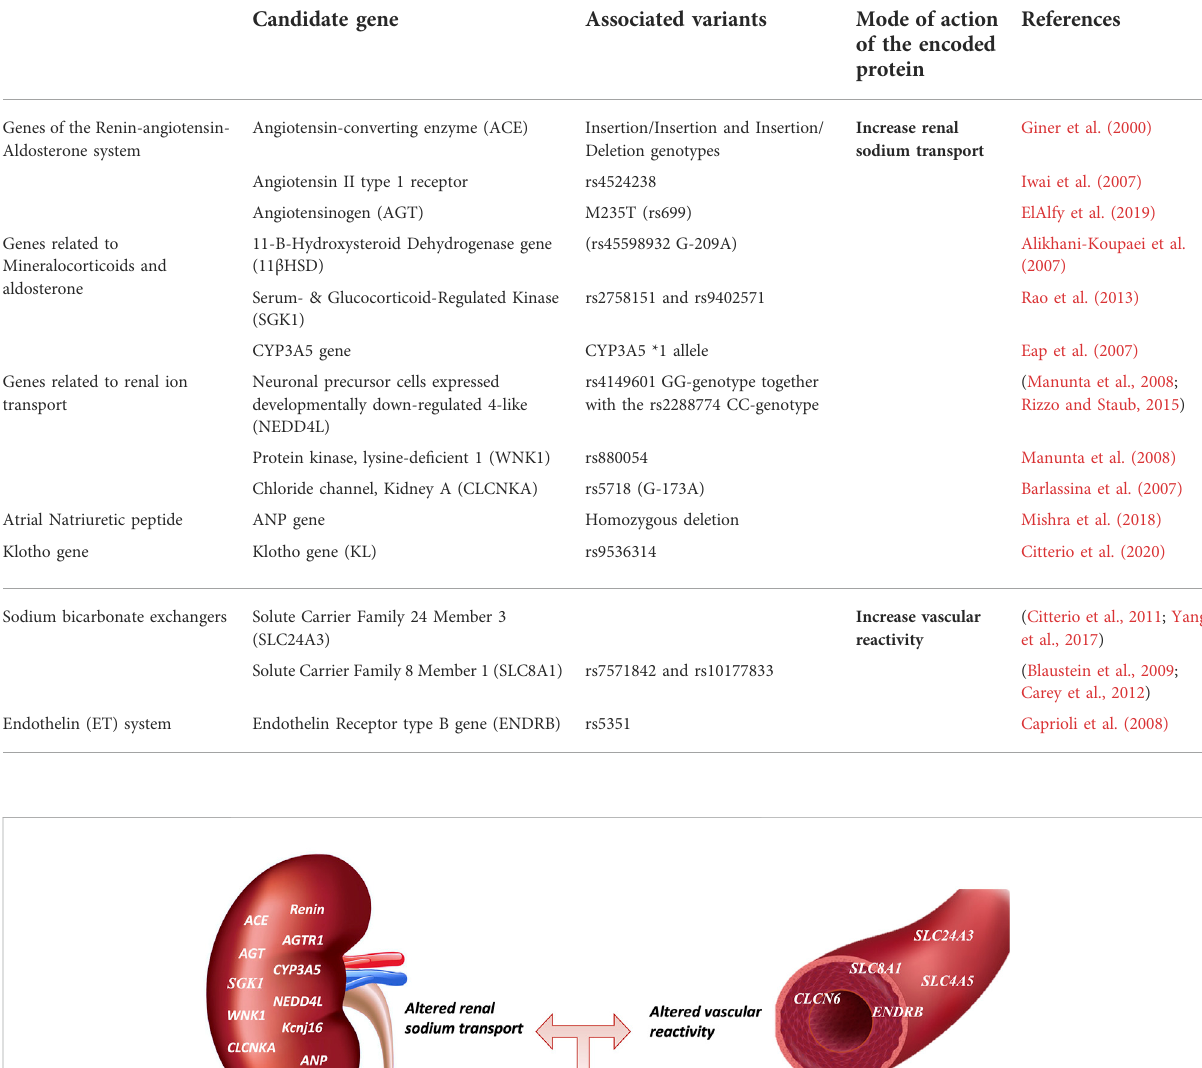
TABLE 2 Allelic variants of candidate genes for HTN in relation to the salt-sensitive phenotype affect renal sodium transport or vascular reactivity.